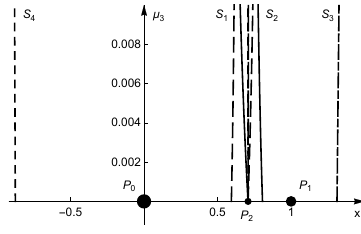
Figure 8. Collinear equilibrium configurations for 0 ≤ µ 3 ≤ 0 . 01, particle P 2 is located near the point L 1 , 0 < a < 1, µ 1 = 0 . 1, µ 2 = 0 . 02.